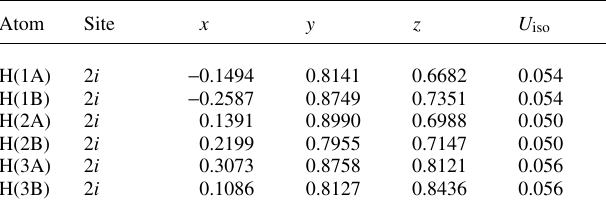
Table 2. Atomic coordinates and displacement parameters (in Å 2 )